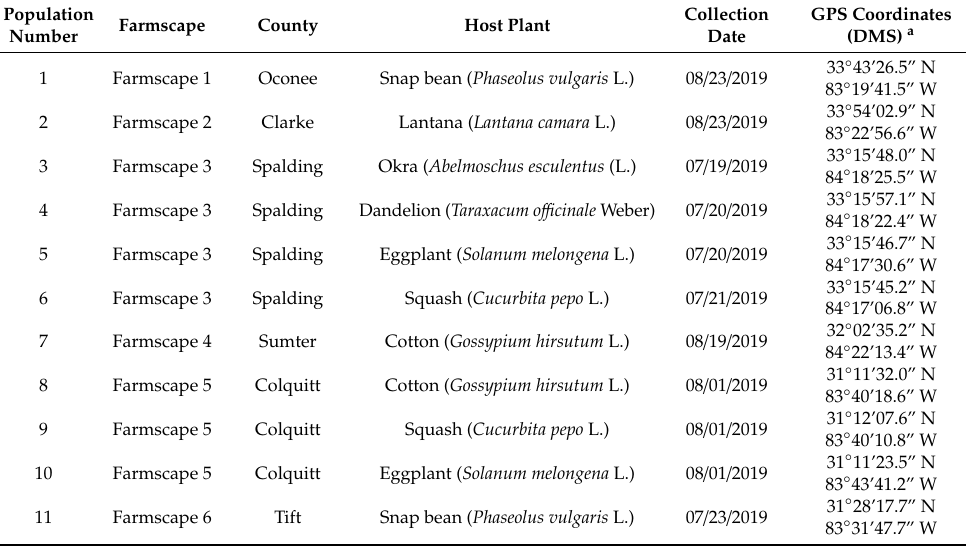
Table 1. Collection data for whiteflies analyzed in this